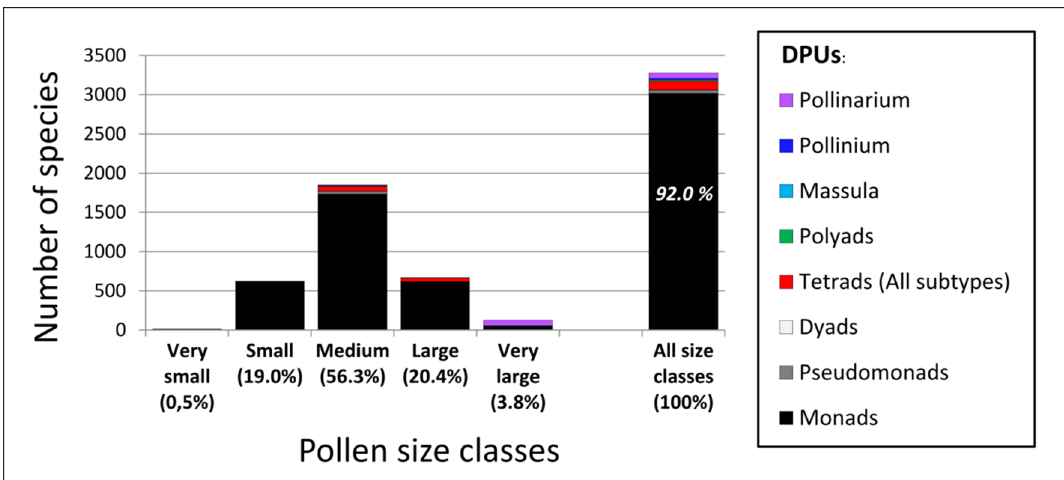
Figure 2. Distribution of the vegetal species per pollen size class (columns) and per pollen dispersal unit (colored bars). This graph is for indicative purposes: the data sampling was limited to the 3280 vegetal species included in the palynological database PalDat (last accessed: 12 June 2020) [34].